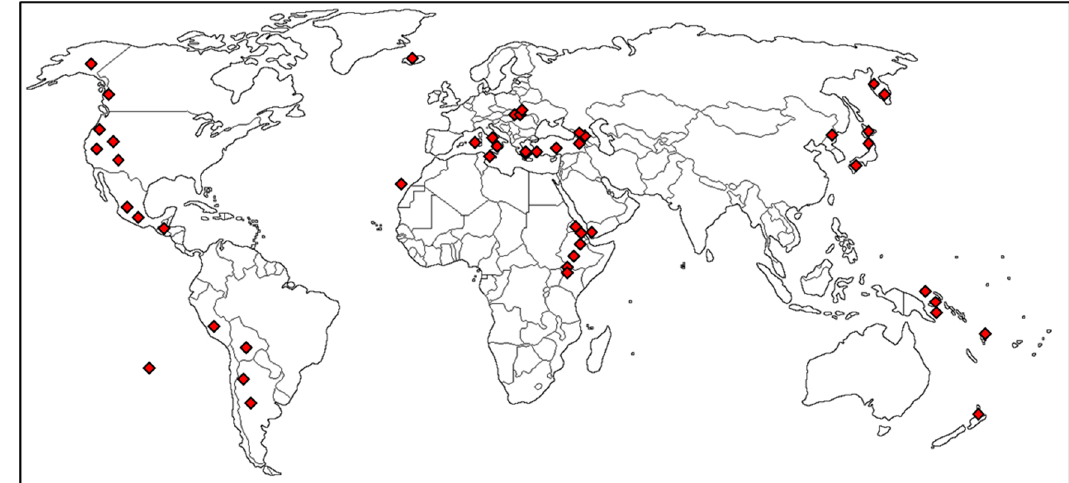
Figure 1. Map showing many of the obsidian source locations used in antiquity. Obsidian was widely used for cutting and scraping tools during the Old and New Stone Ages, starting in the Lower Paleolithic by early Homo (ca. 1.75 million years ago) and continuing until recently in some parts of the world [2]. Due to its higher level of sharpness, compared to chert (flint), quartzite, and other stone tool material, it was intentionally acquired, flaked to produce broken edges, transported, and traded over distances of 1000 km or more within the central Mediterranean [3]. The preparation of cores was generally done near the geological source, with blades and other tools produced by trained lithic workers at many of the distant archaeological sites (Figure 2). Findings of obsidian artifacts at mainland sites in Greece and Italy, from island geological sources in the Mediterranean, infers the development of maritime travel by the late Upper Paleolithic [4] of at least simple crafts, to more complex vessels by the Early Bronze Age (3rd millennium BCE); the earliest remains found in the Mediterranean of open-water boats (or drawings) are only more recent. Obsidian is still used today for surgical procedures (including eye and heart), due to its greater sharpness and faster healing process, compared to stainless steel scalpels (just search online for a commercial scalpel vendor). Obsidian was also used for polished mirror surfaces, and for jewelry in certain cultures even today.